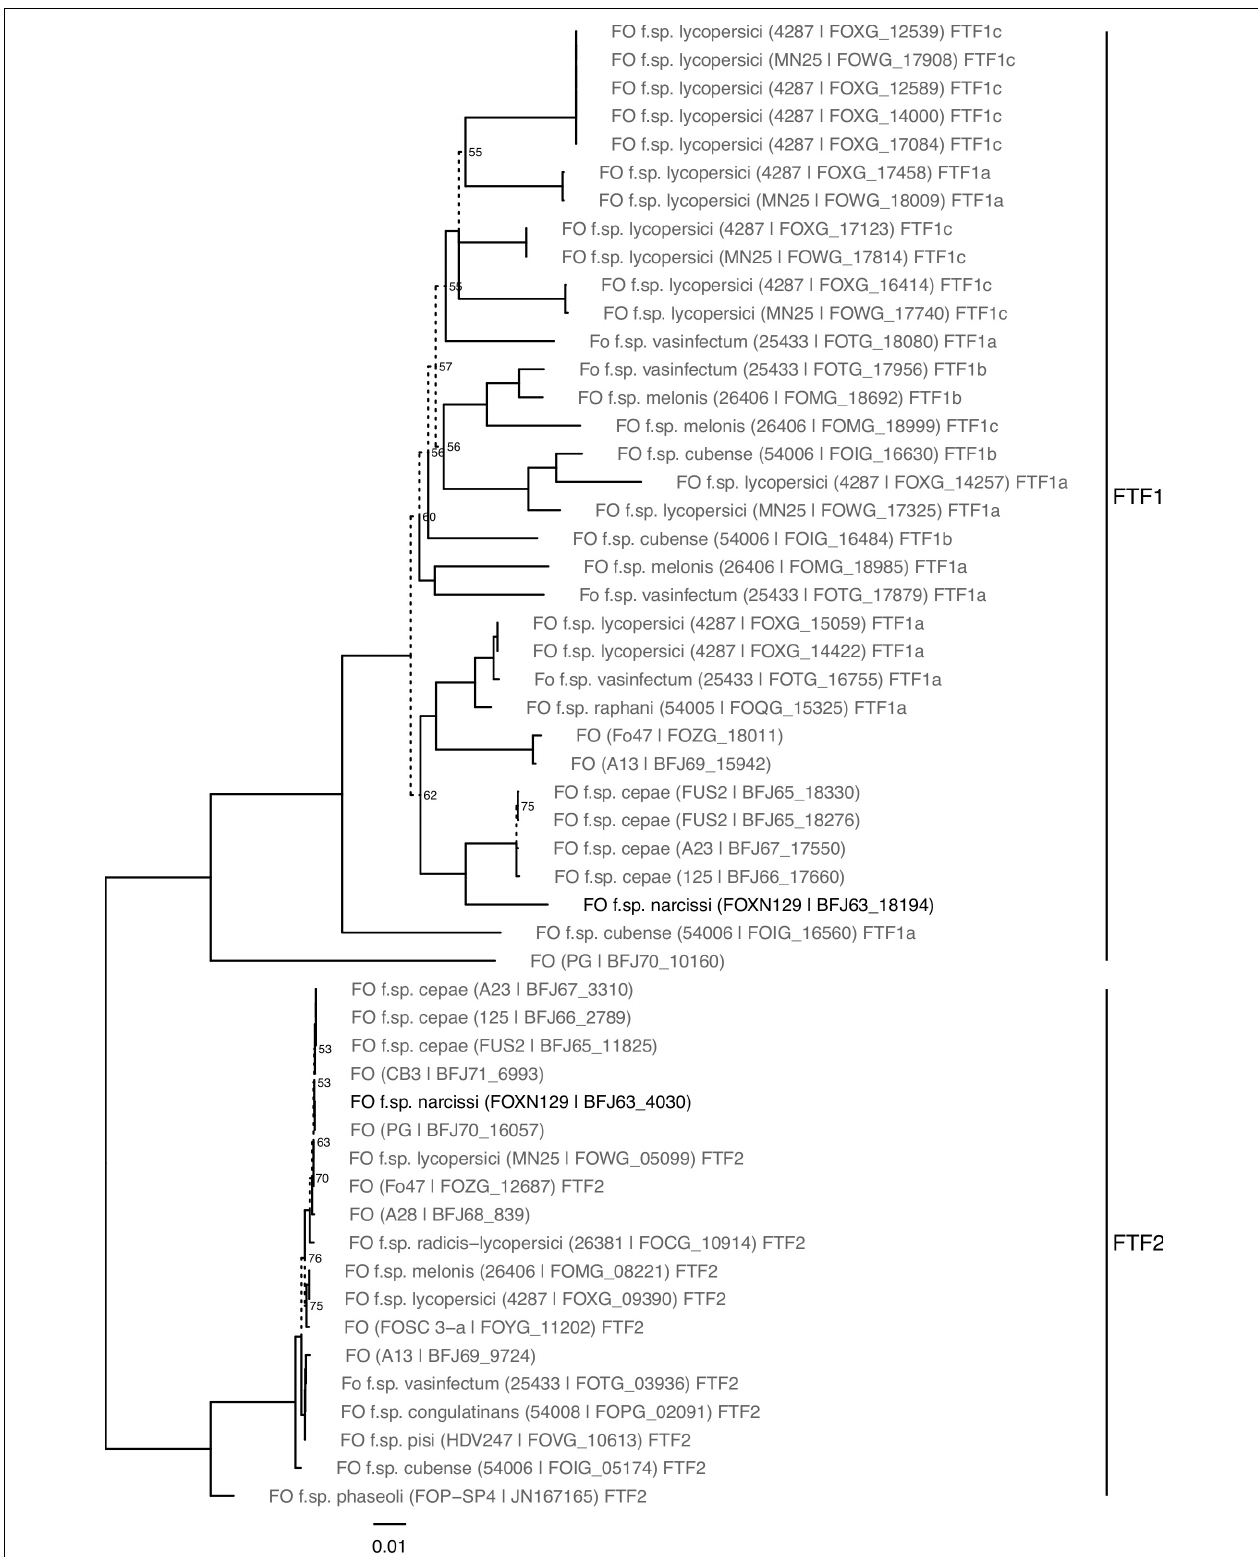
FIGURE 6 | Neighbour joining phylogeny of FTF gene sequences from FON and reference sequences. Branches with bootstrap support under 80% from 1000 replicates are marked with dashed lines and labelled with % support values.